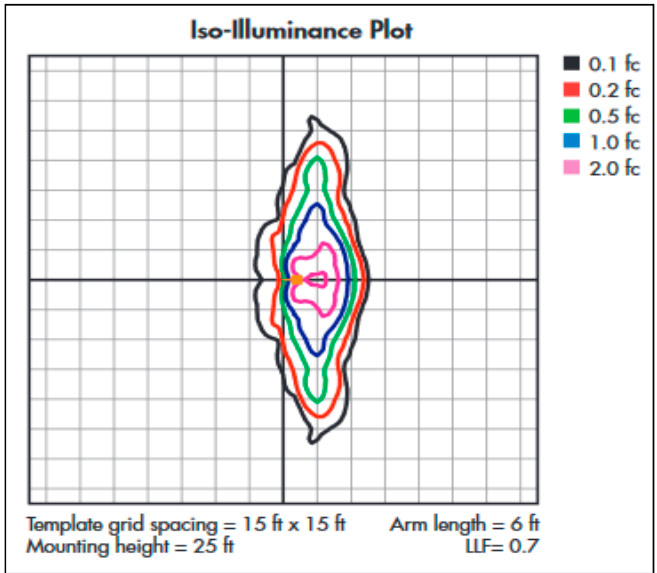
Figure 3. An iso-illuminate plot of LEDs.